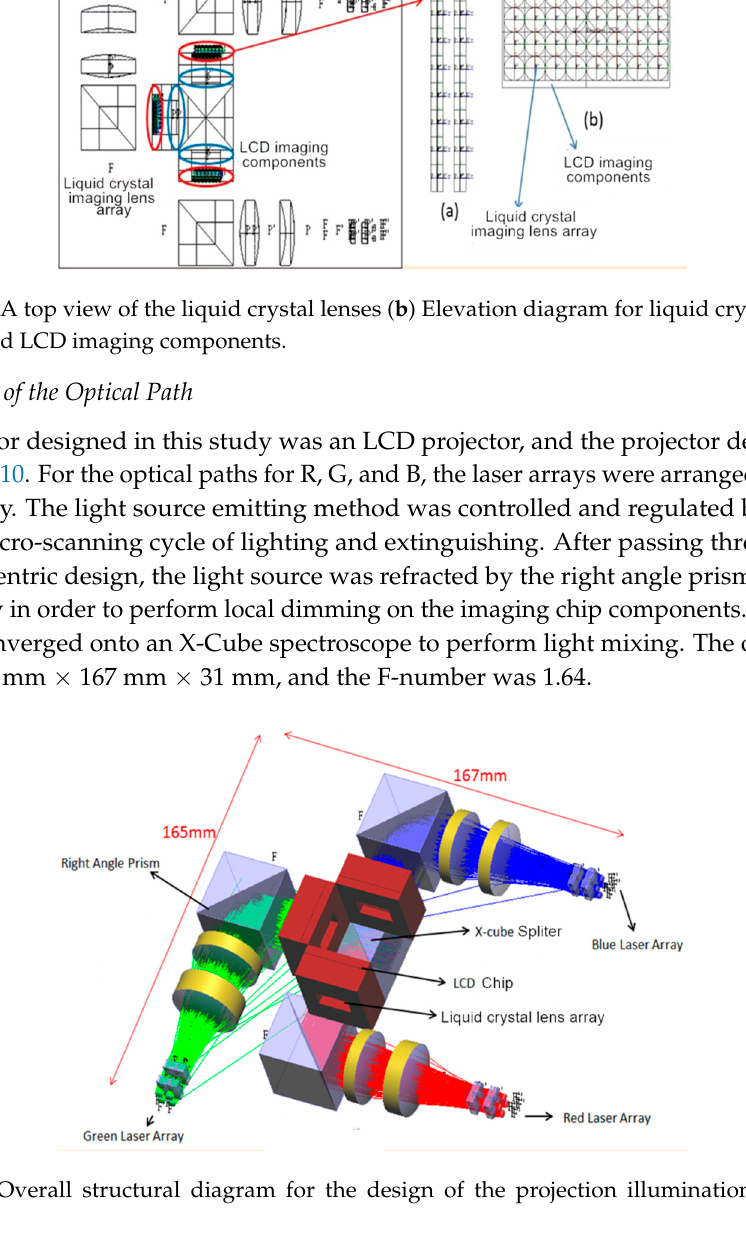
Figure 8. Design structure for a single liquid crystal lens and the liquid crystal lens array.